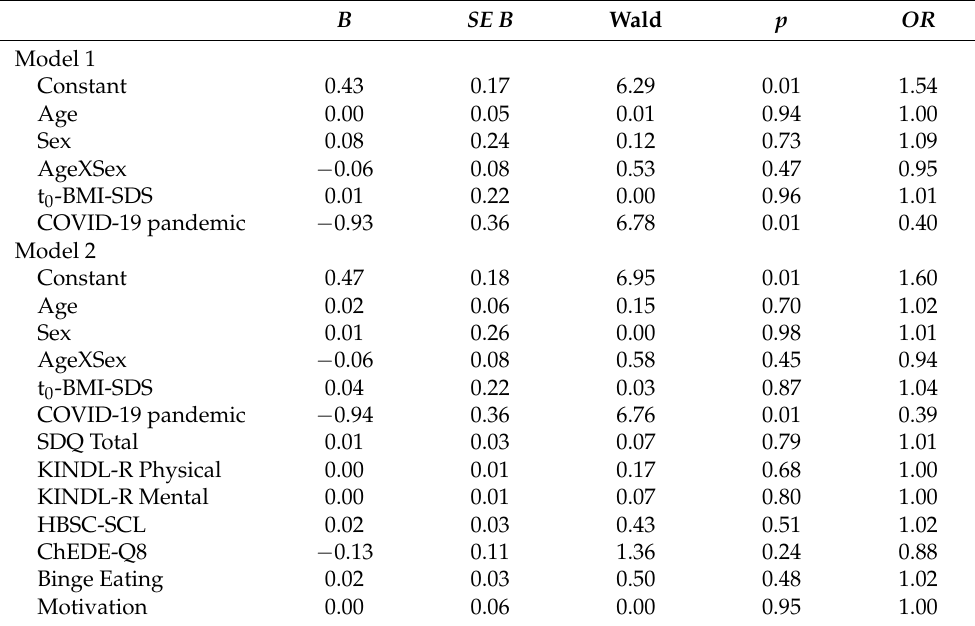
Table 4. Logistic regression analysis for the predictors of treatment adherence (dropout/completer) ( n =